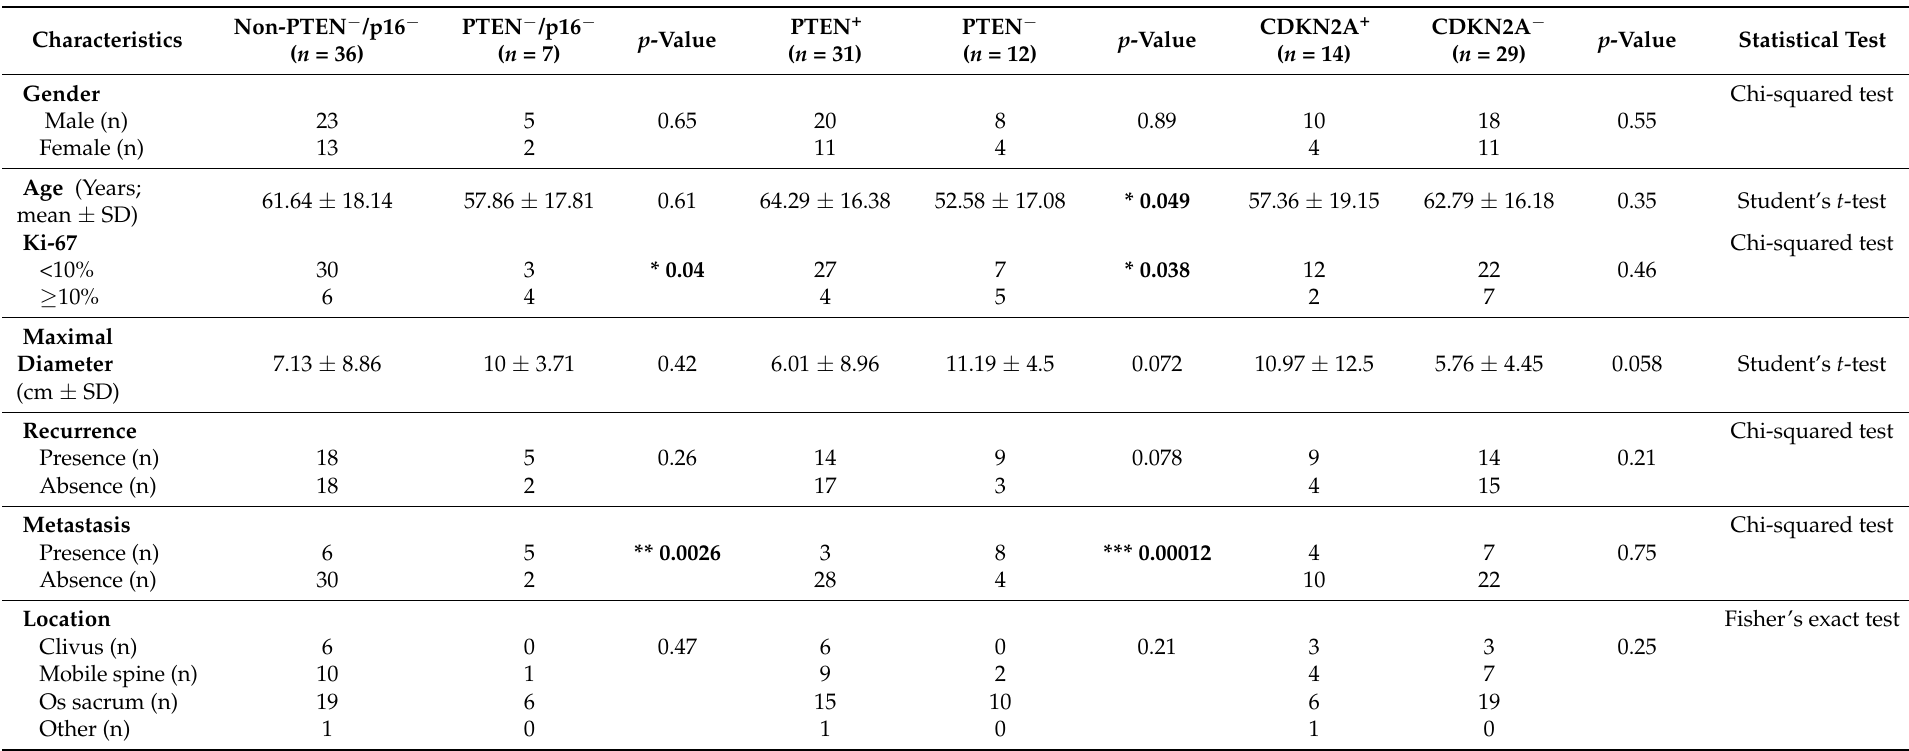
Table 1. Clinicopathological features of chordoma cases with respect to their PTEN and p16 statuses. * p < 0.05, ** p < 0.01, *** p < 0.001, derived from the indicated statistical